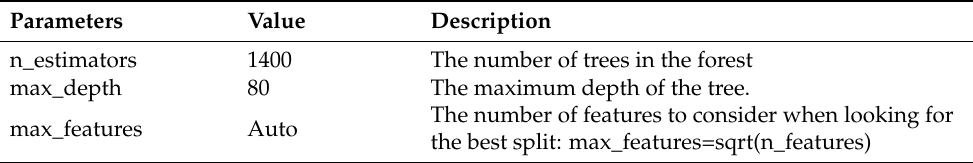
Table 5. Hyperparameters of the random forest classifier.